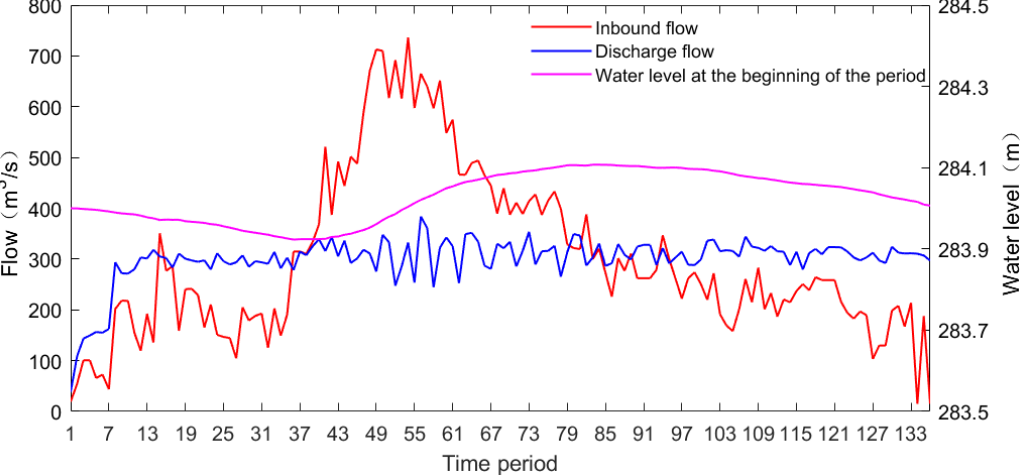
Figure 11. Optimal scheduling results of the first flood with the maximum peak clipping criterion.